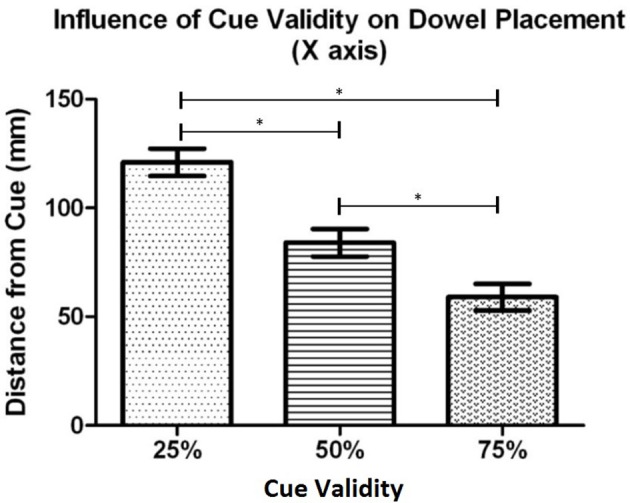
Experiment 1: The mean distance that the dowel was placed from the cued location along the X axis (left and right space) for each cue validity condition. Error bars represent the standard error of the mean. The * indicates a statistically significant difference.